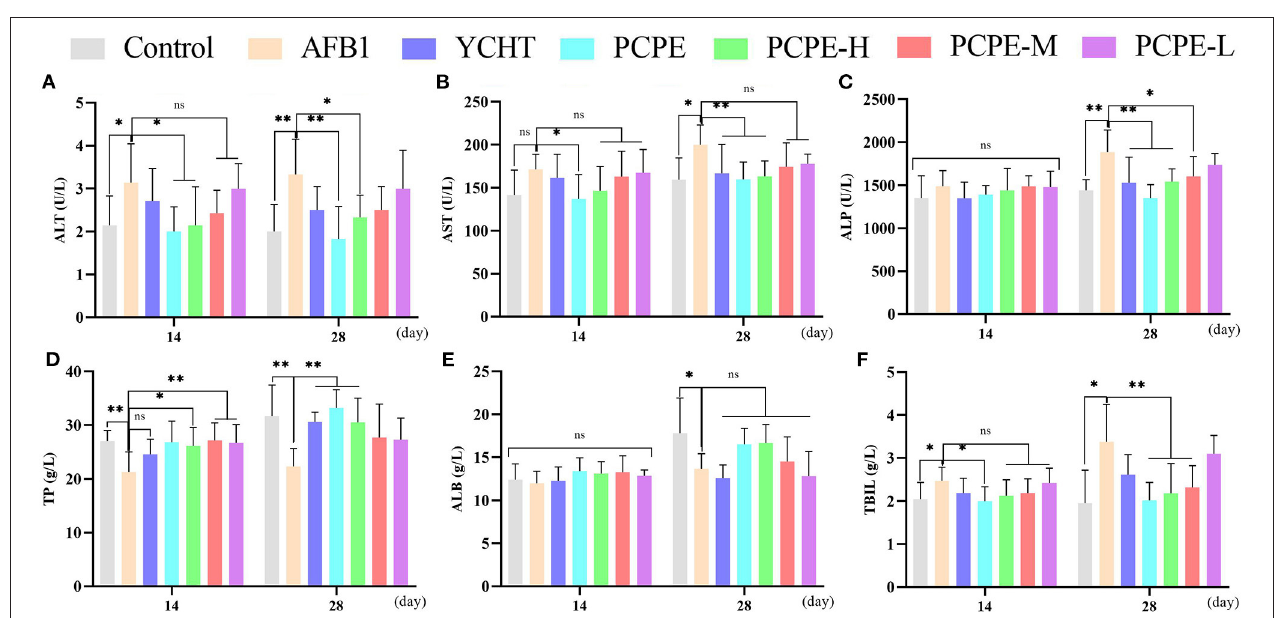
FIGURE 1 | Effect of PCPE on serum biochemistry of broilers feed containing AFB1 and PCPE low, medium, and high dose (1g, 2g, 3g PCPE/kg feed, respectively). Values are represented as the mean ± SD. (A) ALT; (B) AST; (C) ALP; (D) TP; (E) ALB; (F) TBIL. * P < 0.05; ** P <